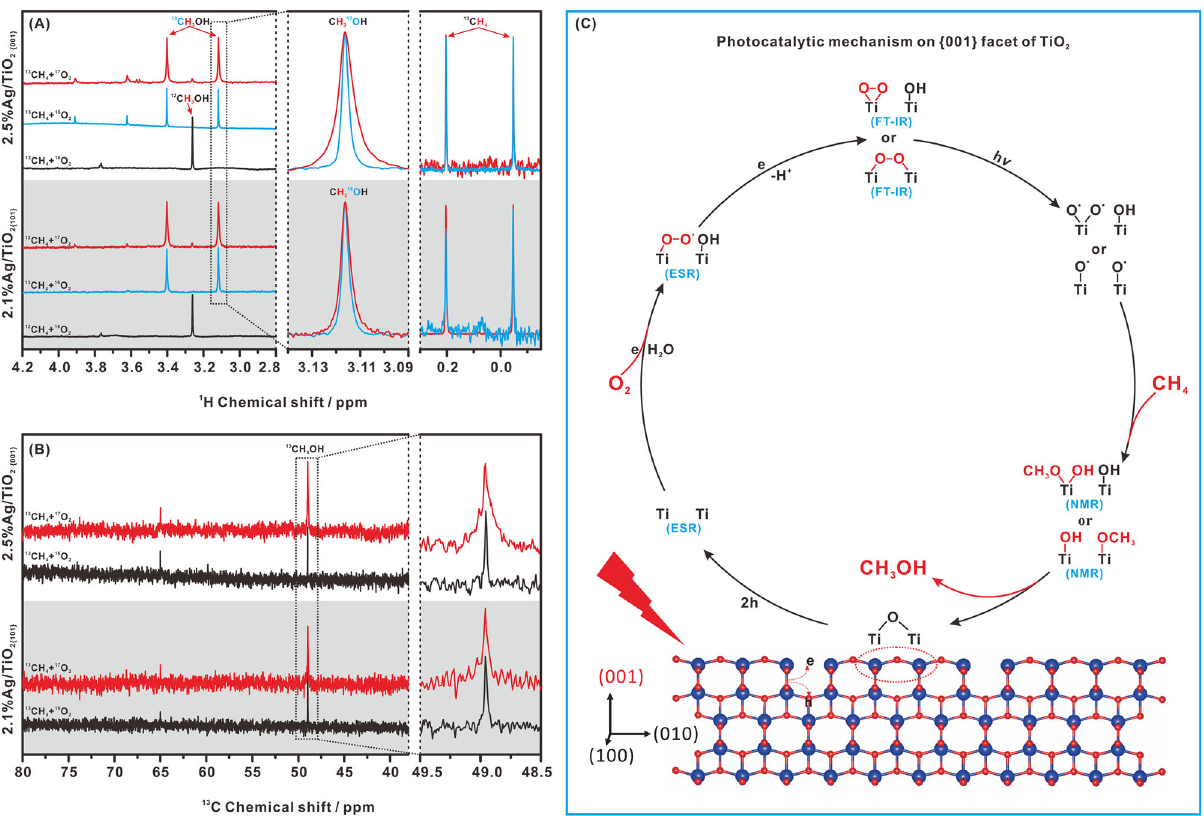
Fig. 4 Photocatalytic mechanism. A 1 H and B 13 C NMR spectra for the product obtained from photocatalytic CH 4 oxidation at a 4 h reaction time using 50 mL water, 80 kPa CH 4 , 20 kPa O 2 , and 10 mg Ag/TiO 2 . C Proposed photocatalytic mechanism for CH 4 oxidation by O 2 on the {001} facets of TiO 2